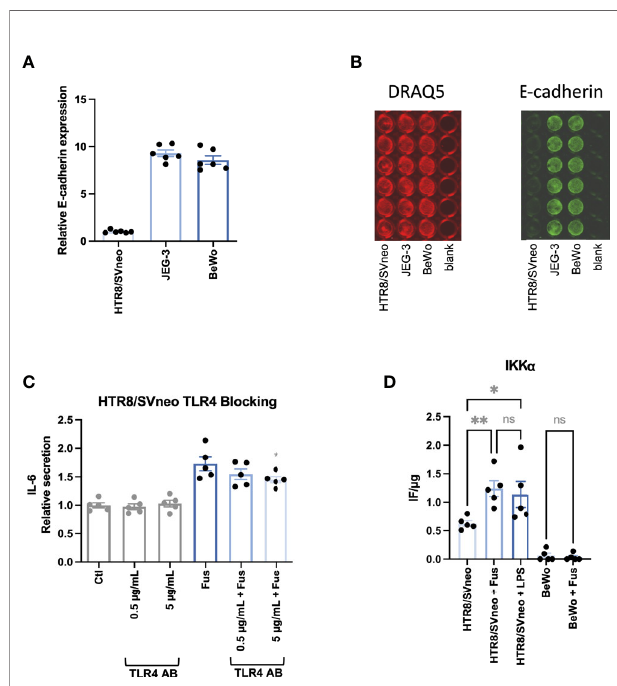
FIGURE 5 | BeWoand JEG-3 cells, but not HTR8/SVneo cells express high levelsofE-cadherin.IL-6 secretion in response to bacterial stimulation of HTR8/ SVneo is partially TLR4 dependent. Bar graphs show E-cadherin expression in trophoblast celllines normalized to HTR8/SVneo (A) . E-cadherin expression was normalized to cellnumber detected by cellnuclei staining with DRAQ5. Illustrative image of fl uorescence signals of DRAQ5 binding and E-cadherin In-CellWestern analysis (B) . IL-6 secretion was assessed in HTR8/SVneo after stimulation with F. nucleatum inthe presence or absence of a TLR4-blockingantibody (C) . The presence ofthe activated formofIKK a on HTR8/SVneo and BeWo cells was assessed after stimulation with F . nucleatum orLPS (D) . Data are presented as mean ± SEM.The experiment was performed once in sextuplicate (A) , sixtimes intriplicate (C) or fi ve times in duplicate (D) . *p adj < 0.05; **p adj < 0.01; ns, not signi fi cant, as analysed by RepeatedMeasures ANOVA with Dunnett ’ s (C) or S ̌ ida ́ k ’ s (D) multiplecomparison post test. Data comparison in (C) was performed on F . nucleatum treated cells employing thegroup without TLR4- blockingantibodyas control( “ Fus ”